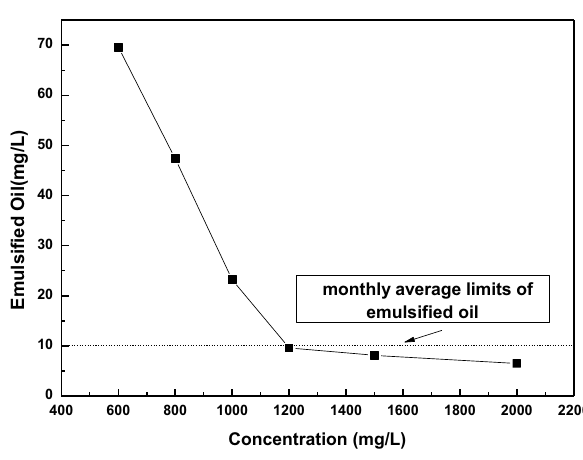
Fig. 2 Influence of the concentration of NIS emulsified